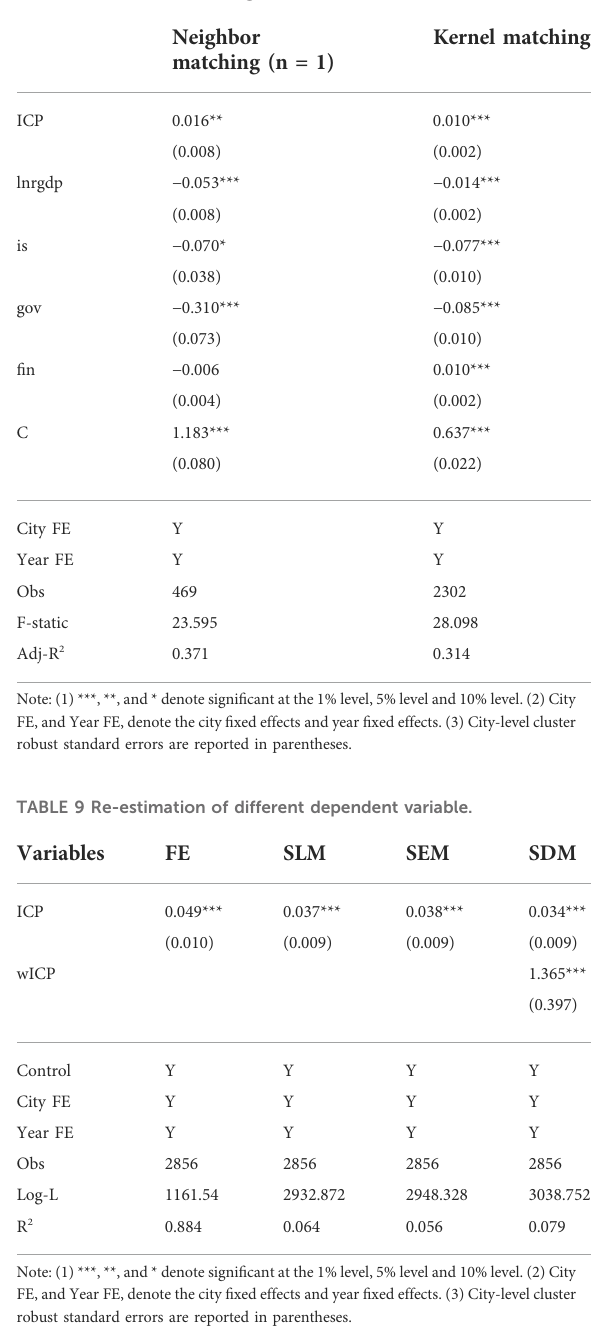
TABLE 8 Re-estimation using PSM-DID.